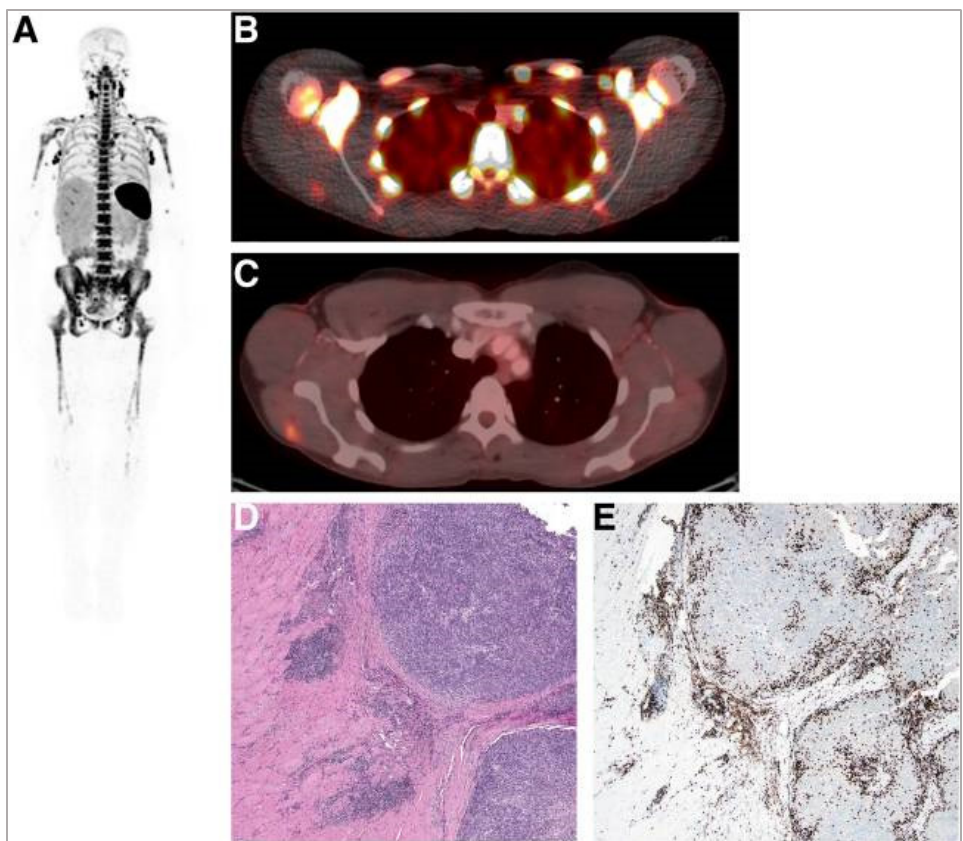
Figure 6. A whole-body image (maximum-intensity projection) in one patient at 24 h post injection of 0.2 mg of [ 89 Zr]Zr-DFO-IAB22M2C demonstrating intense signals in lymph nodes ( A ). Fusion image demonstrates the uptake of [ 89 Zr]Zr-DFO-IAB22M2C in lesions in the deltoid ( B ) that also showed [ 18 F]FDG uptake ( C ). ( D ) Haematoxylin- and eosin-stained section demonstrates melanoma tumour nodules on right within skeletal muscle. ( E ) Immunohistochemistry staining shows the presence of CD8+ T cells at the periphery and infiltrating tumour. Reproduced from Pandit-Taskar et al. [133].